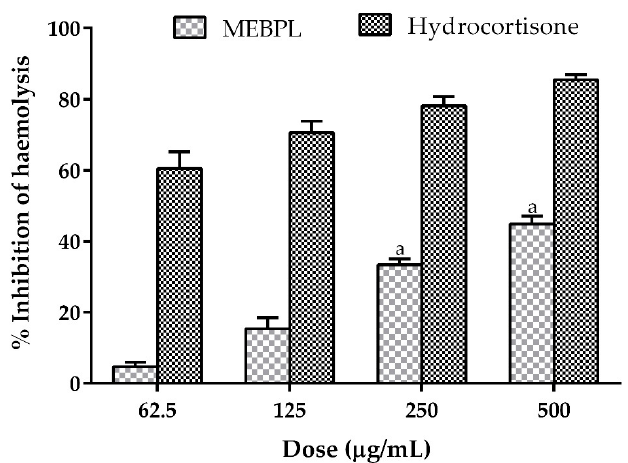
Figure 1. Percentages of inhibition of haemolysis of the erythrocyte membrane by methanol extract of B. pilosa leaves (MEBPL) and standard drug hydrocortisone. Results are mean ± SEM ( n = 3). a p < 0.05, significantly different from control.